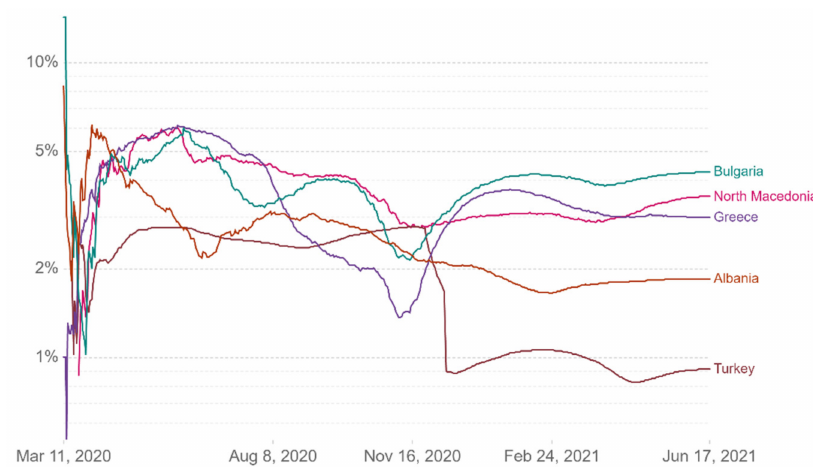
Figure 10. Case fatality rate.